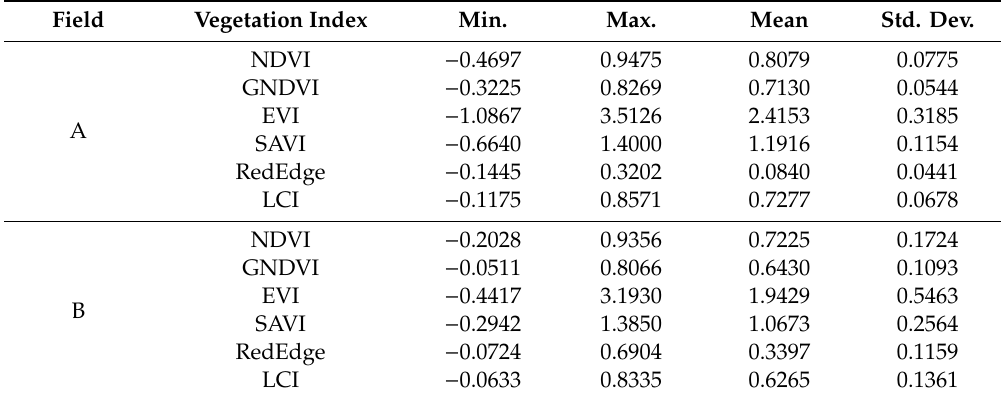
Table 3. Descriptive statistics of six vegetation indices in two experimental